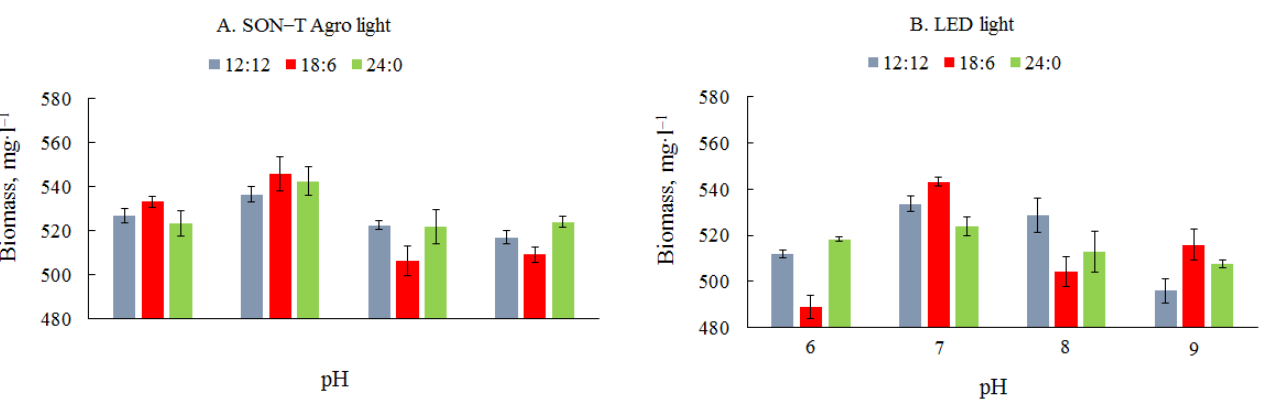
Figure 3. Biomass productivity under optimal culture conditions in SON-T Agro light ( A ) and LED light ( B ).